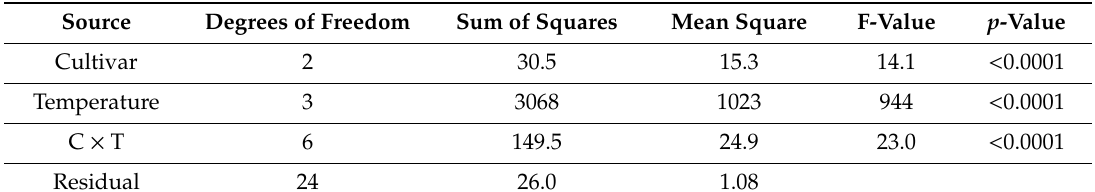
Table A6. Analysis of variance for photosynthetic rates measured at 500 µ mol mol − 1 C i for three soybean cultivars grown at 25 °C.